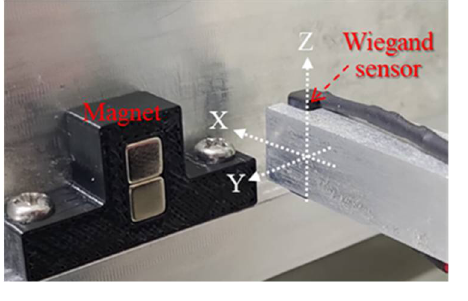
Figure 7. Precision displacement platform carrying the Wiegand sensor.